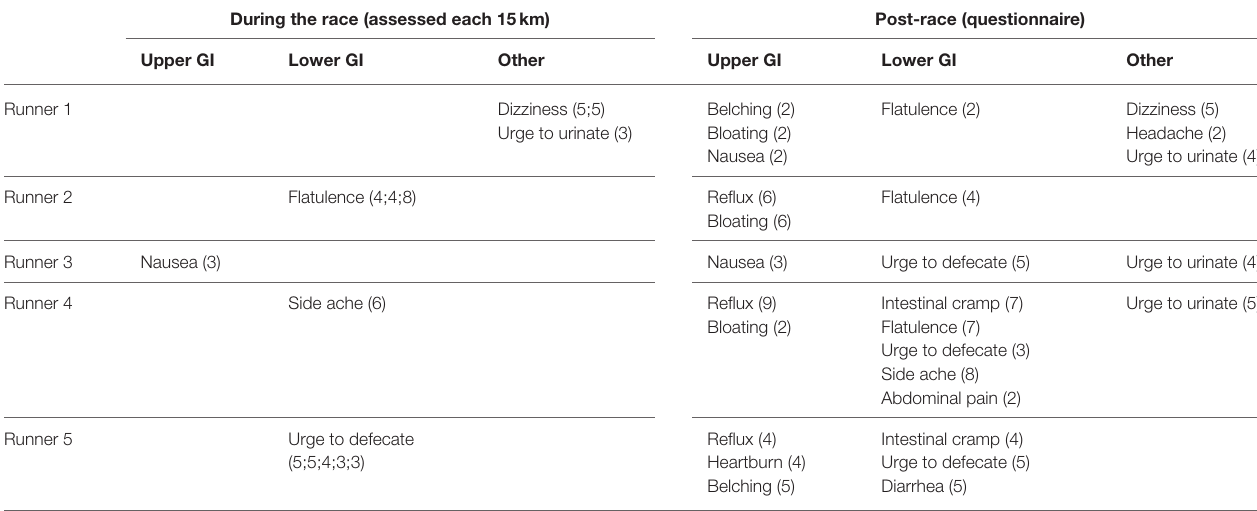
TABLE 4 | Gastro intestinal complaints assessed during the race and based on a post-race questionnaire ( n = 5). During the race (assessed each 15km) Post-race